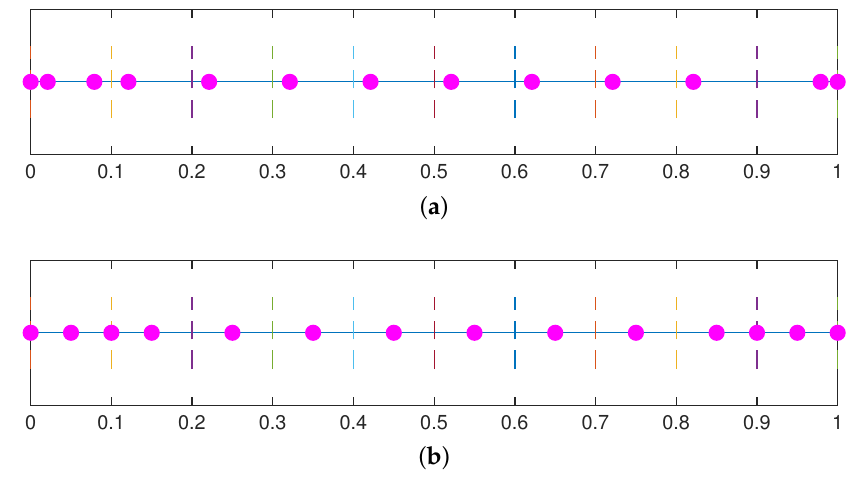
Figure 7. ASC points. ( a ) Odd degree ( p = 3). ( b ) Even degree ( p =